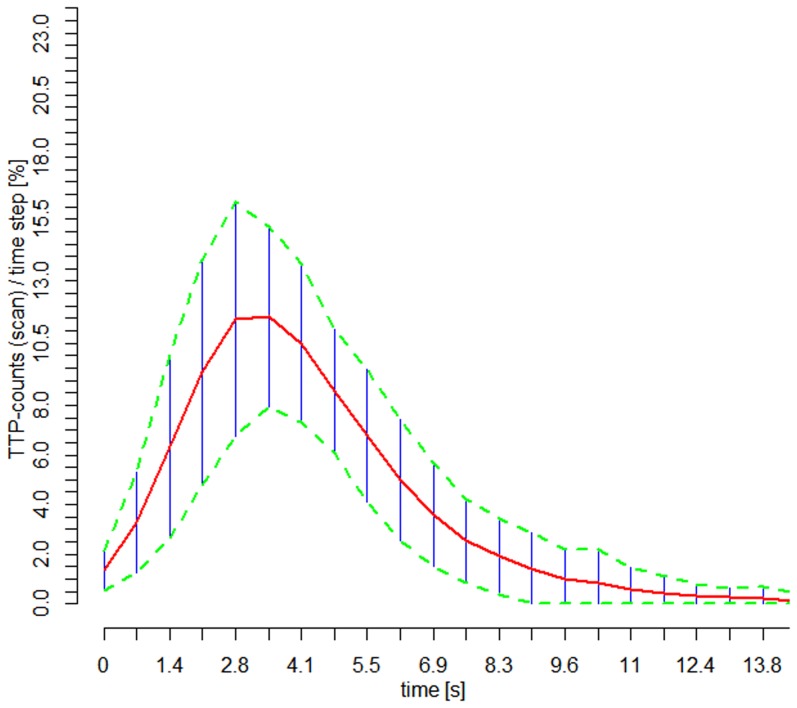
When overlaid within comparable time intervals, the raw time-to-peak distribution curves (TDC) showed considerable variance, but their similarity of the basic structure is evident, which is also reflected by the moderate correlation across patients (ρ = 0.86; Spearman rank correlation; n = 61).The mean curve (red line) and the interval: mean −/+1*SD (green dashed lines) are shown.